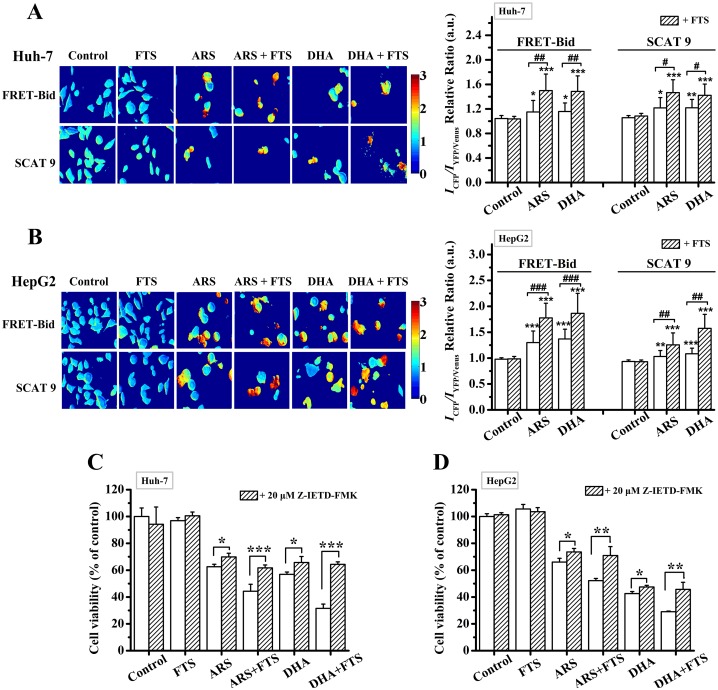
FTS promotes DHA/ARS-induced caspase-8 and -9 activations.(A and B) ICFP/IYFP/Venus ratio images of cells expressing FRET-Bid or SCAT9 (left) and corresponding statistical results (right) from at least 250 cells in Huh-7 (A) and HepG2 (B) cells. Cells were transfected with FRET-Bid and SCAT9 plasmid for 24 h respectively and then treated with DHA/ARS for 24 h in the presence or absence of FTS before fluorescence microscopic imaging. *P < 0.05 and ***P < 0.001, compared with control; #P < 0.05, ##P < 0.01 and ###P < 0.001. (C and D) Cells were pretreated with Z-ITED-FMK (caspase-8 inhibitor, 20 μM) for 30 min before FTS/DHA/ARS treatment or the combination treatment of DHA/ARS and FTS for 48 h and then analyzed by CCK-8 assay. *P < 0.05, **P < 0.01, and ***P < 0.001.